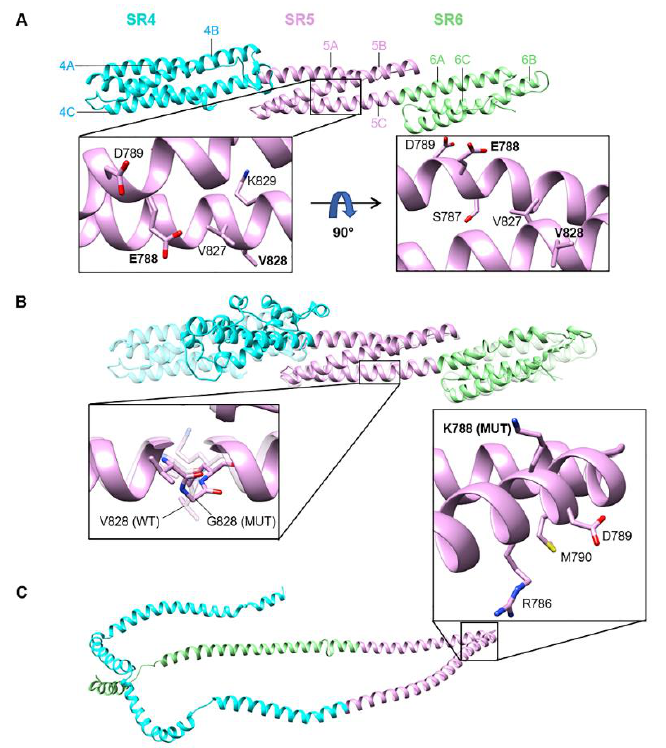
Figure 2. Structural models of spectrin repeats SR4-SR5-SR6 for wild-type and mutant nesprin-2 giant proteins. ( A ) Wild-type (WT) SR4-SR5-SR6 with major helices labelled. WT residues within the affected region of SR5 (helices 5B and 5C) are presented in two orientations (90°-rotated; inset). Residues E788 and V828 (altered in mutants) are shown in bold. ( B ) Superposition of V828G mutant (solid) and WT (transparent) SR4-SR5-SR6 structures. SR4 and helix 6B (SR6) conformations are distorted in the V828G mutant, whilst SR5 is structurally homologous to WT. The peptide backbone (as well as residue side-chains) is presented in ‘stick’ form for positions 827–829 to distinguish between mutant glycine and WT valine at position 828 (inset). G828 mutant (MUT) and V828 (WT) residues (labelled) are depicted as solid and transparent structures, respectively. ( C ) E788K mutant SR4-SR5-SR6, showing complete loss of the typical triple-helical SR structure. K788 (MUT) and neighbouring residues are shown (inset). A superposition with the WT structure was not possible, due to extreme conformational differences. All structural models were predicted using PHYRE2. Stick representations are coloured by element (bound hydrogens are not depicted): carbon = pink, nitrogen = blue, sulfur = yellow, oxygen = red. For all structures, SR4 = turquoise, SR5 = pink, SR6 =